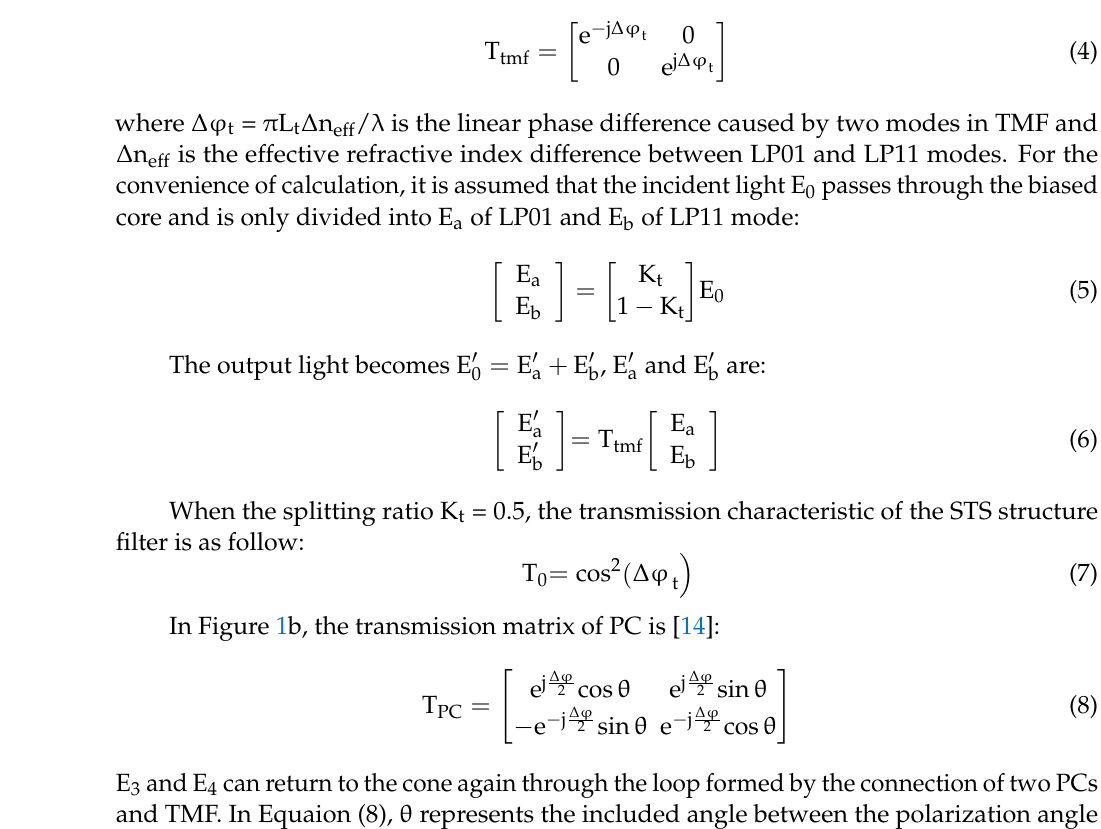
Figure 2. ( a ) Simulated spectrum of the TMCL. ( b ) Measured transmission spectrum of the TMCL. In order to make the composite filter, the ring area of the TMCL needs to be cut to The Jones matrix of TMF can be represented by a phase retarder form two additional output terminals, which are respectively connected with PC and then offset welded with the TMF (FM SI-2, YOFC) to construct STS structure. The incident light will excite LP01 mode and LP11 mode at the first splicing point when there is a slight offset fusion between the SMF and TMF, then these modes are coupled with each other and experience energy exchange. Because of the different propagation constants between the two modes, the relative phase of the light changes in the propagation process, result- ing in mode interference at the second splicing point. The core diameters of SMF and TMF are 8.2 µm and 14 µm, respectively. The difference between them provides convenience for the preparation of STS.